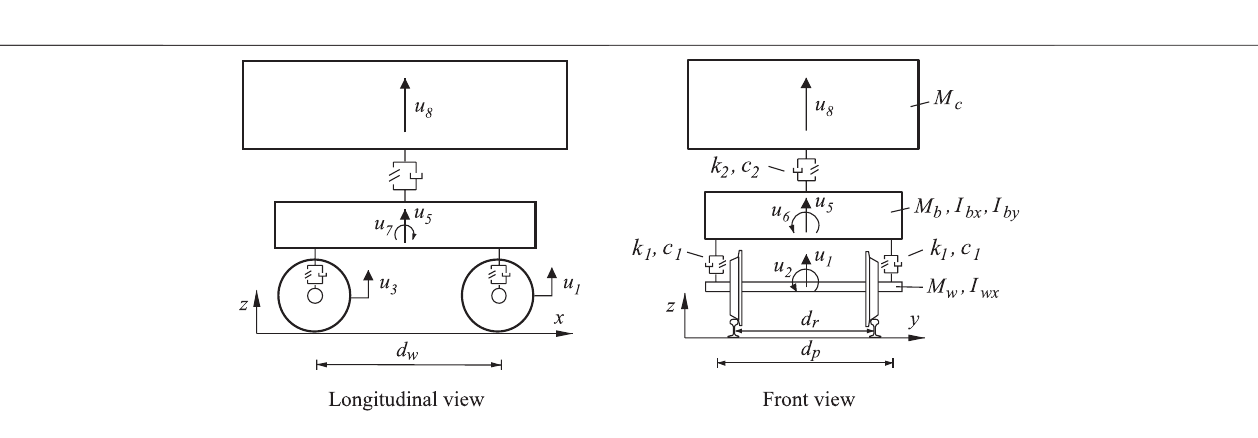
FIGURE 2 | Model of the vehicle representing a bogie and half